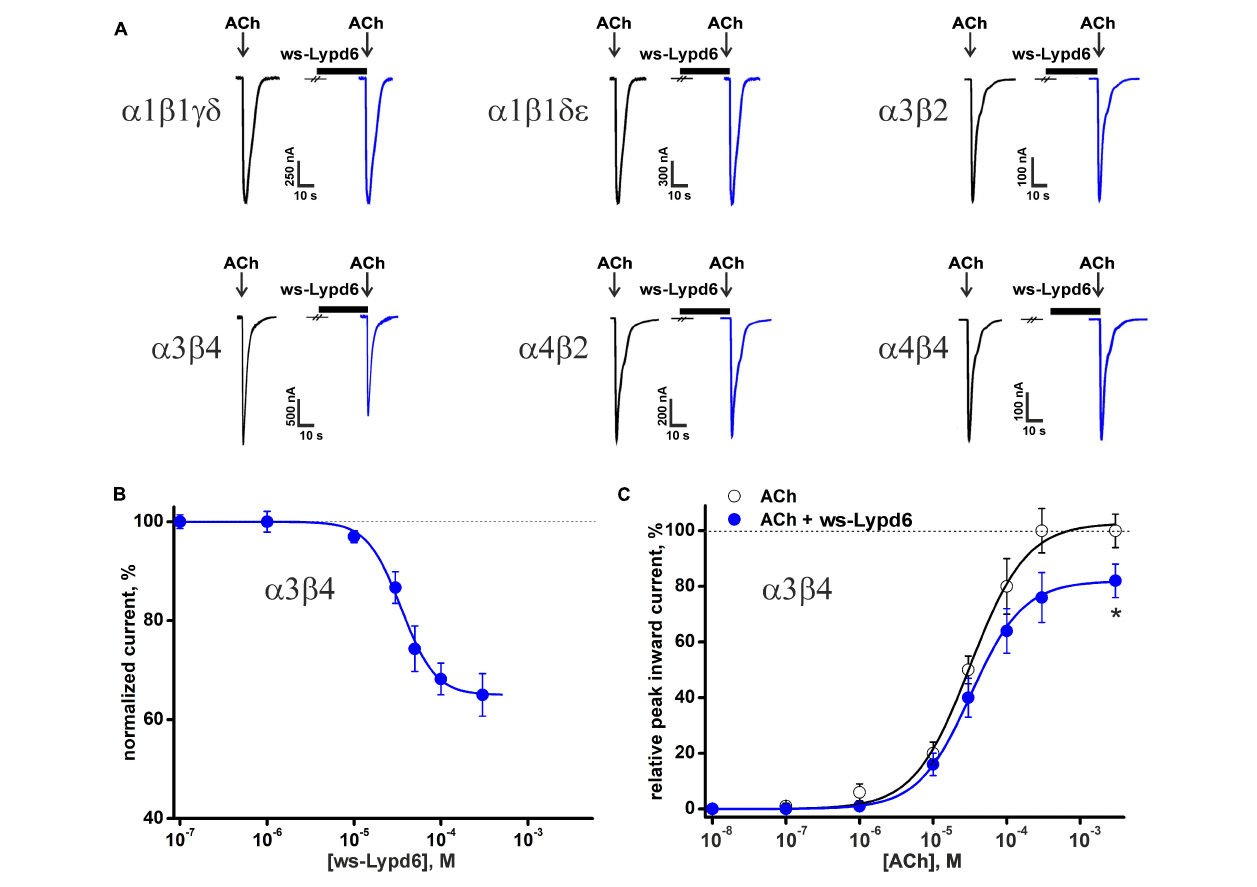
FIGURE 1 | Effect of ws-Lypd6 on heteromeric nAChRs expressed in X. laevis oocytes. (A) Representative responses to 100 ms pulses of ACh (100 µ M for α 1 β 1 γδ , α 1 β 1 δε , α 3 β 2, α 3 β 4; 10 µ M for α 4 β 2, and α 4 β 4) recorded in the presence or absence of 30 µ M ws-Lypd6. Pre-incubation time of oocytes with ws-Lypd6 was 5 min. (B) Dose-response curve for ws-Lypd6 inhibition of ACh-evoked currents at α 3 β 4-nAChRs. The data are normalized to the peak amplitude of current recorded without ws-Lypd6 (100%) and presented as mean ± SEM ( n = 6 oocytes). The data were fitted by the Hill’s equation resulted in IC 50 for ws-Lypd6 of 34.9 ± 1.2 µ M, A 0 of 33 ± 5%. (C) Dose-response curves of ACh at α 3 β 4-nAChRs in absence (open symbols) and presence of 35 µ M ws-Lypd6 (closed symbols). The peak inward current amplitudes were normalized to the peak current obtained by the application of 1 mM ACh and plotted against the different concentrations of ACh applied in control. The concentration-response curve in presence of ws-Lypd6 was normalized to the control. The obtained EC 50 values for ACh are 29.8 ± 4.7 µ M and 31.3 ± 6.2 µ M in absence and presence of ws-Lypd6, respectively. * ( p < 0.05) indicates significant difference from the control value (100%, max. response for ACh without ws-Lypd6) (one sample t -test).